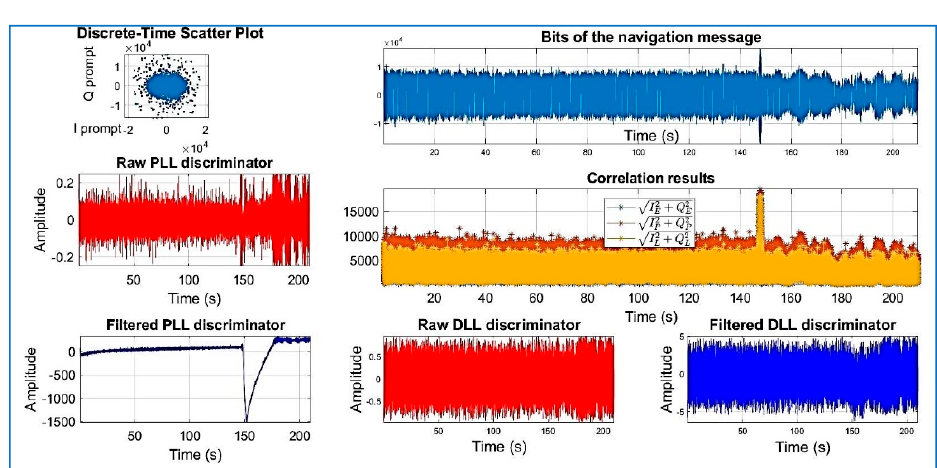
Figure 22. PRN 03, channel 05, Dataset 3. Sensors 2018 , 18 , x FOR PEER REVIEW